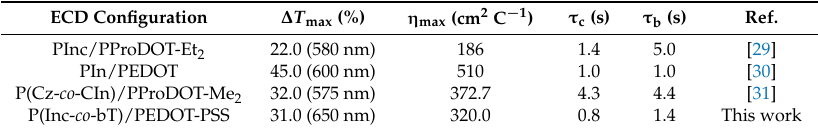
Table 4. Electrochemical optical contrast and coloration efficiencies of ECDs.